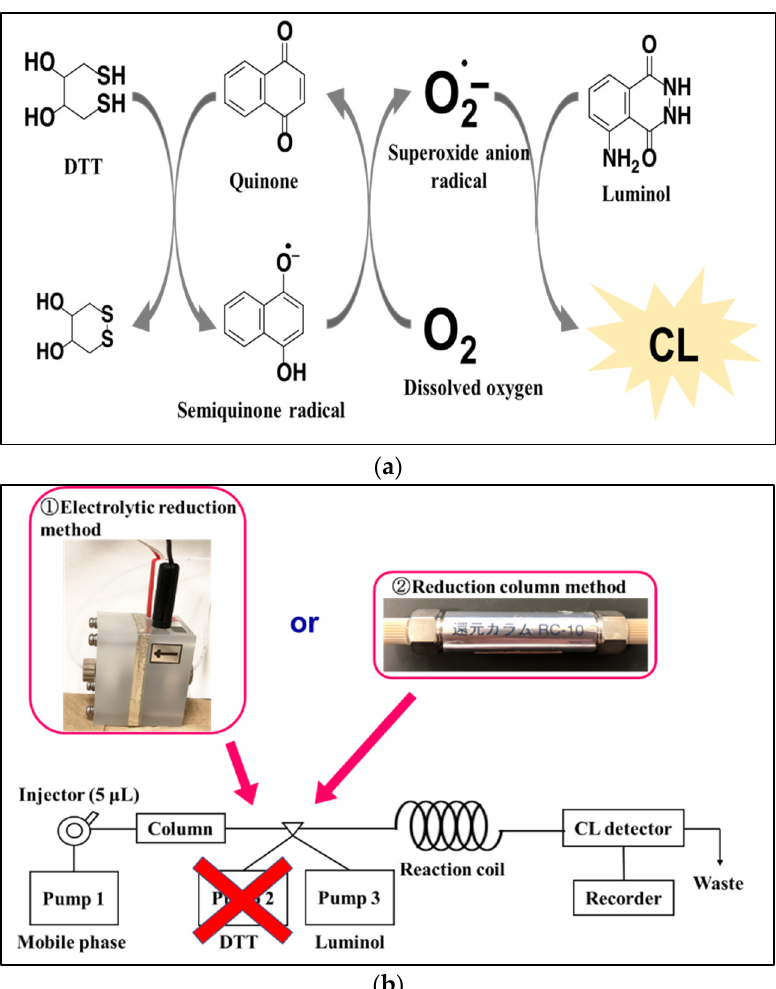
Figure 1. The CL (chemiluminescence) platforms for quinone determination, where ( a ) the mechanism of CL reaction for quinone based on the generation of superoxide anion radical through their redox cycle with DTT (dithiothreitol), and ( b ) HPLC−CL (high-performance liquid chromatography chemiluminescence) system of the proposed methods, including the classical chemical-based reduction using DTT and its replacement with the online electrolytic reduction and reduction column.